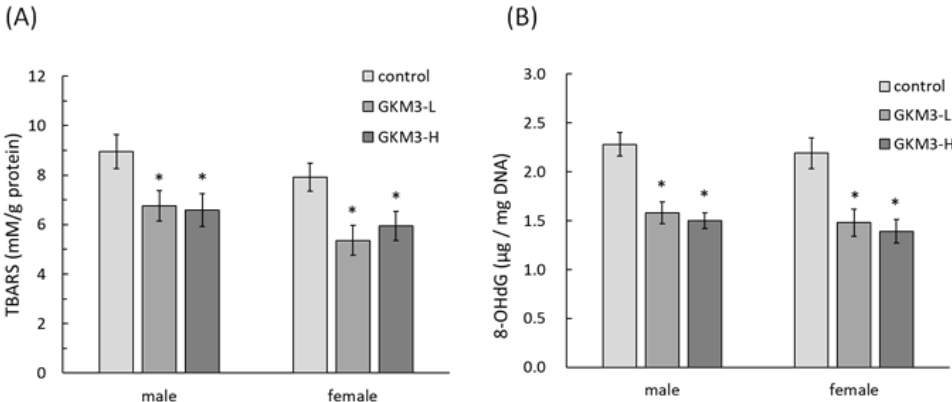
Figure 4. The TBARS ( A ) and 8-OHdG ( B ) level in SAMP8 mice brains after 14 weeks of probiotic GKM3 consumption. Values are presented as mean ± S.E.M. (n = 5). * p < 0.05 was regarded as a significant difference (one-way ANOVA). GKM3-L: 1.0 × 10 9 CFU/kg BW/day (low dose); GKM3-H: 5.1 × 10 9 CFU/kg BW/day (high dose). Abbreviations: TBARS, thiobarbituric acid reactive substances and 8-OHdG, 8-hydroxy- 2′ -deoxyguanosine.